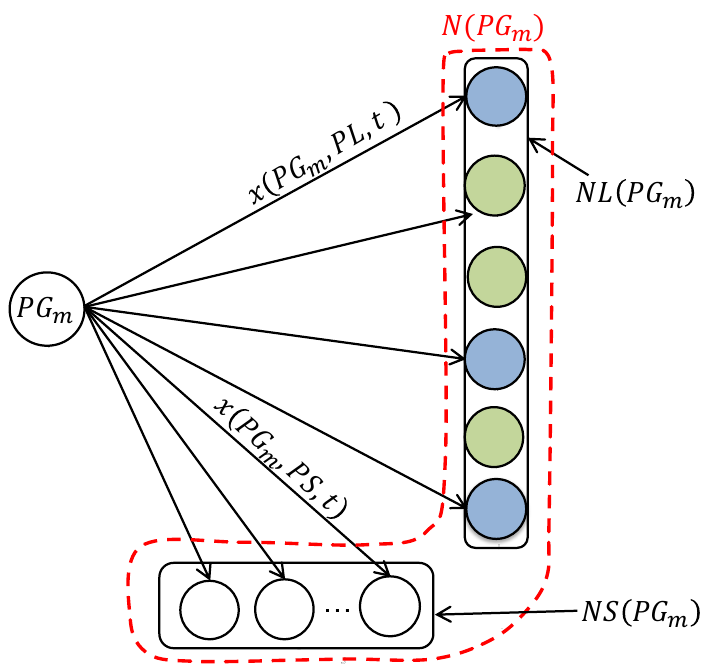
Figure 6. Power generators with neighboring power devices and connections between them.